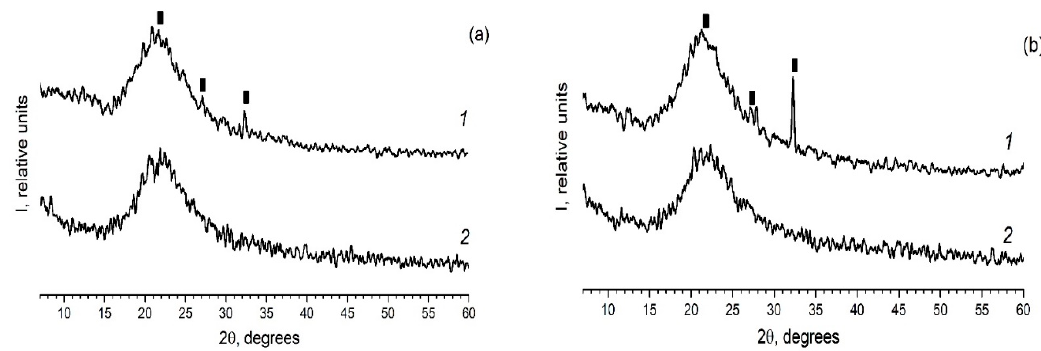
Figure 2. Diffractograms of the composites ( a ) PG-MIP05 and ( b ) PG-MIP1. 1–surface of the sample (plate); 2–volume of the sample (i.e., powder). Black rectangular points refer to the crystalline phase KNO 3 (3–482).